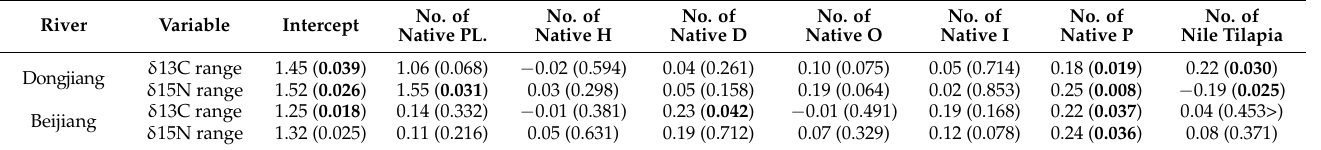
Table 3. Effects of Nile tilapia and native species of different trophic levels on δ 15 N range, δ 13 C range, and the total isotopic niche of native species in the invaded Dongjiang River and the reference Beijiang River tested using mixed effect models.